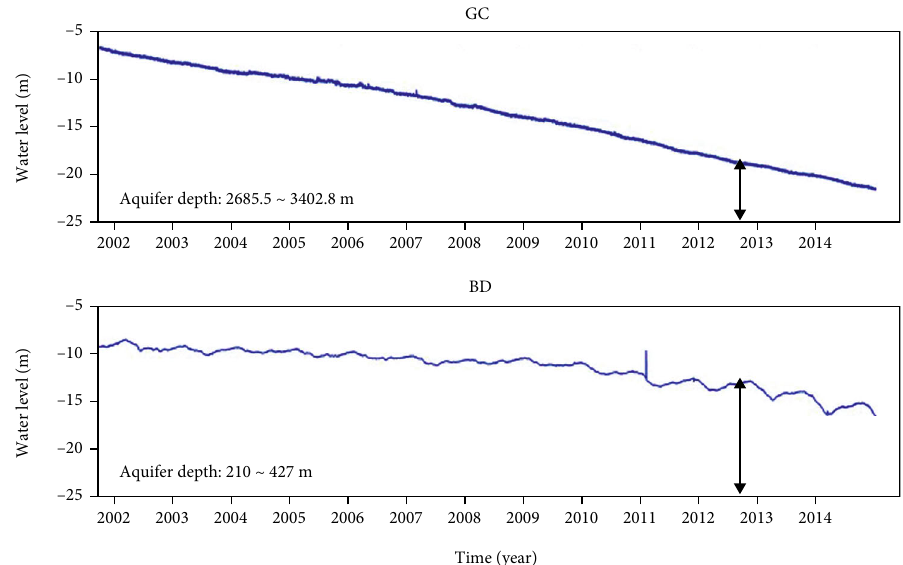
Figure 11: The original water level of well GC and well BD (the above shallower layer) during the years 2002 ~ 2015 shows a decreasing pattern. The y -coordinate numbers indicate the distance between the water head and the ground.